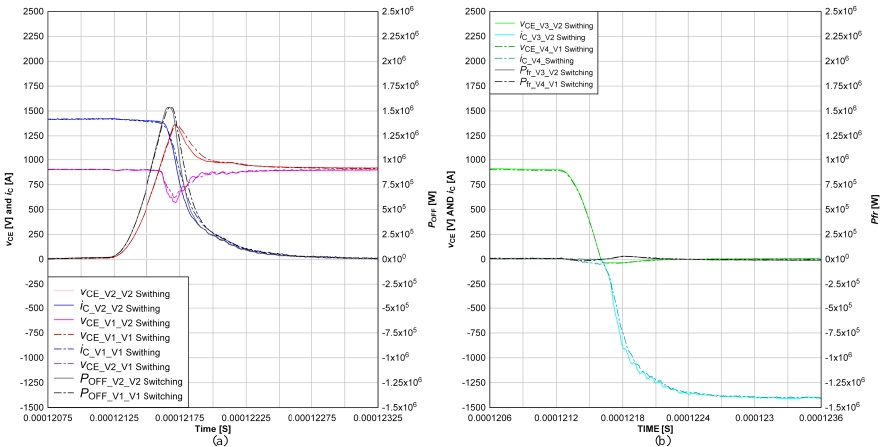
Figure 24. Influence of the stray inductance during IGBT turn-off at 0.9 kV and 1.4 kA (T vj = 25 °C, V GEoff =−15 V, and R Goff = 1.57 Ω). ( a ) Detail waveforms through IGBT. ( b ) Detail waveforms through FWD.